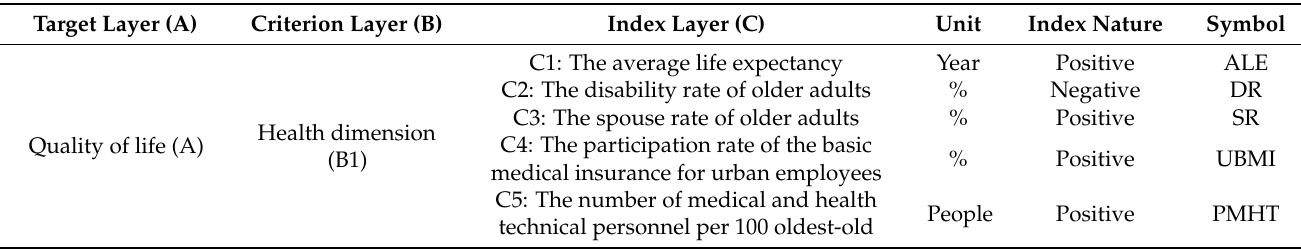
Table 1. Evaluation index of quality of life for the oldest-old in China. Target Layer (A) Criterion Layer (B) Index Layer (C) Unit Index Nature Symbol C1: The average life expectancy Year Positive ALE C2: The disability rate of older adults % Negative C3: The spouse rate of older adults Health dimension C4: The participation rate of the basic Quality of life (A) % Positive UBMI (B1) medical insurance for urban employees C5: The number of medical and health People Positive technical personnel per 100 oldest-old